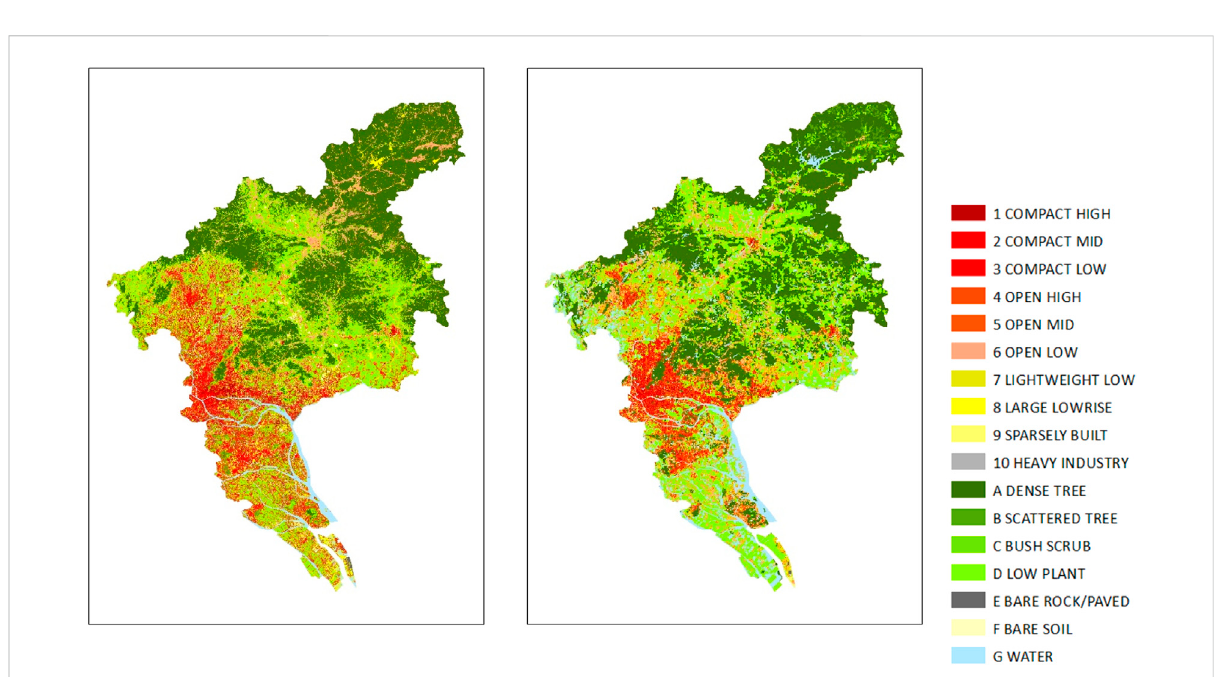
FIGURE 2 Conceptual framework.